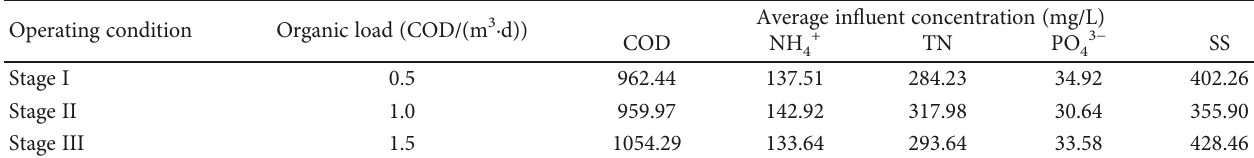
Table 1: Summary of the tested schemes.